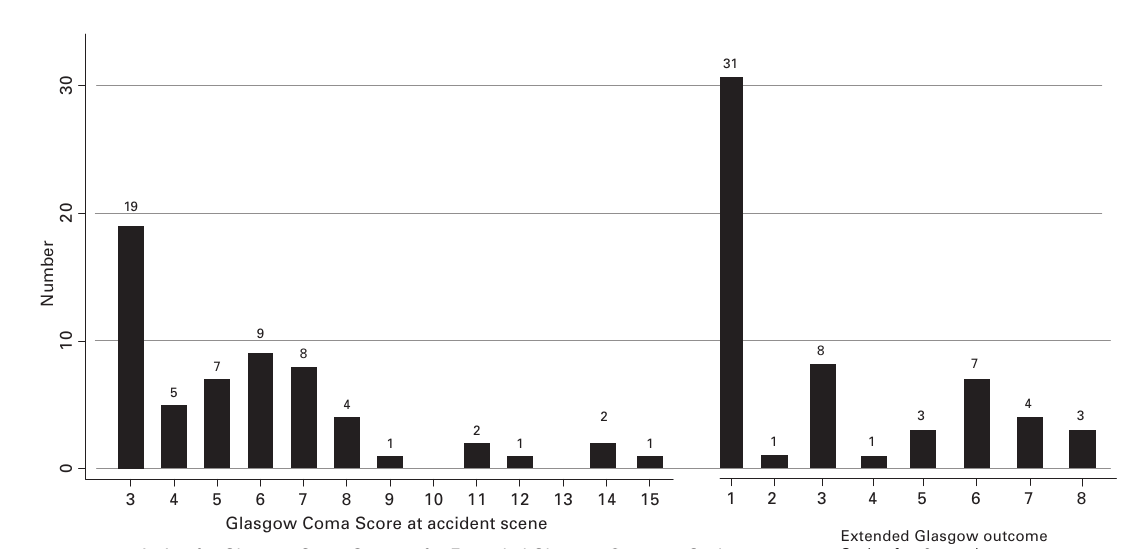
n=60; 1 missing for Glasgow Coma Score, 2 for Extended Glasgow Outcome Scale